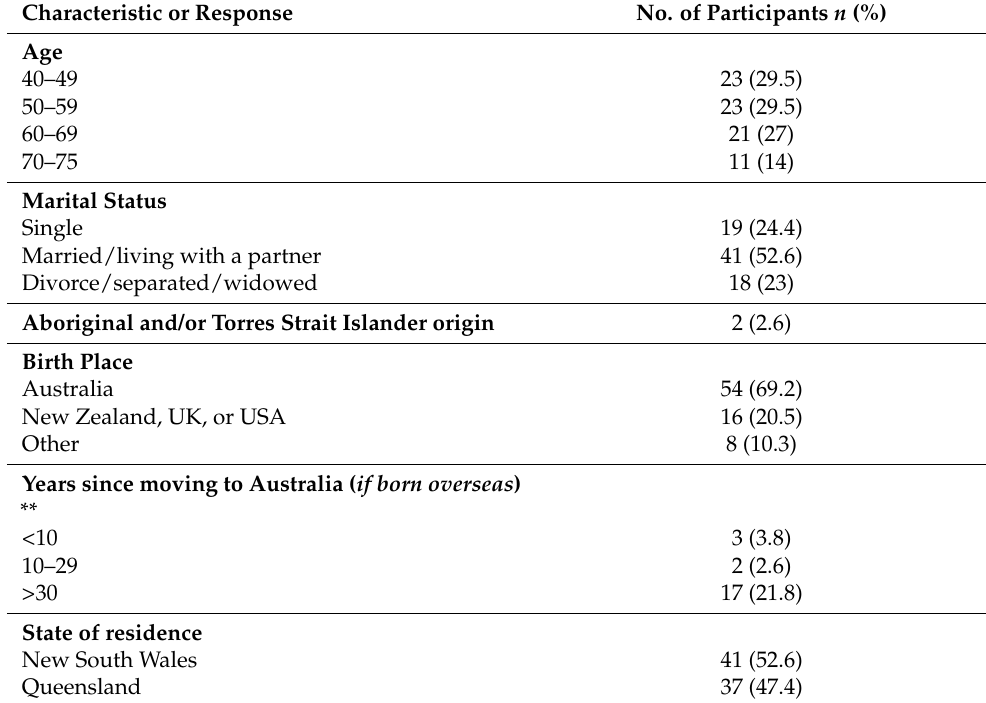
Table 1. Participants’ characteristics ( n = 78)